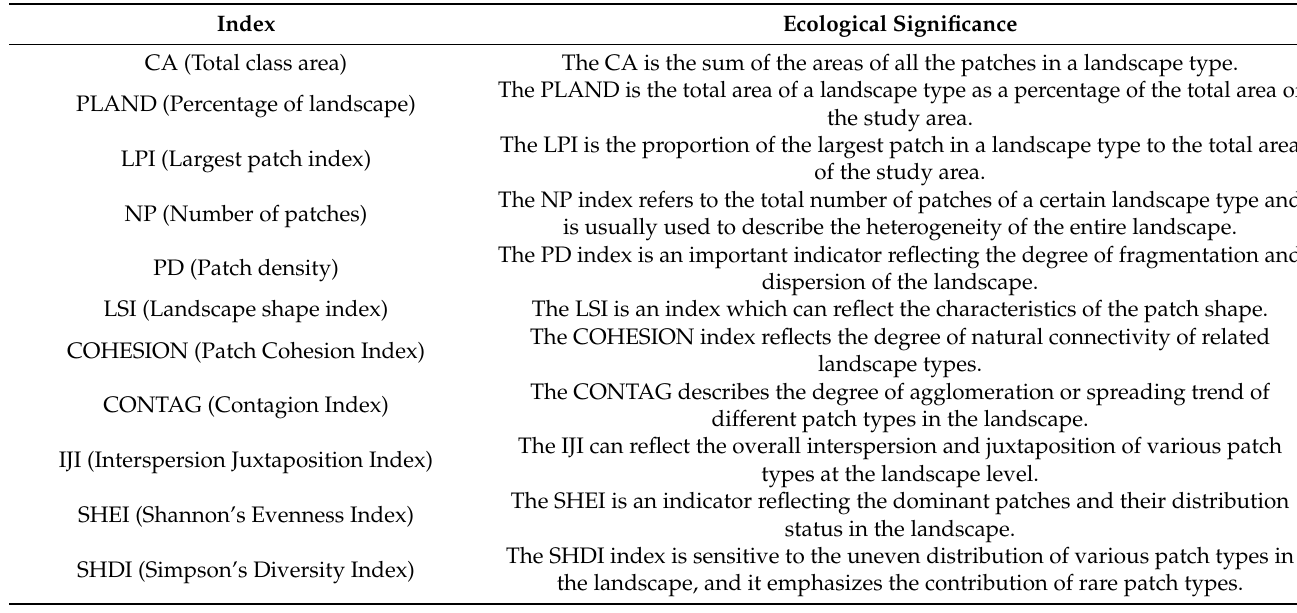
Table 2. The ecological significance of the landscape pattern